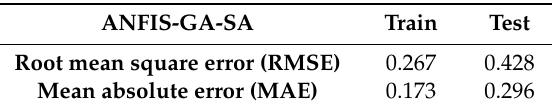
Table 8. Result of the validation